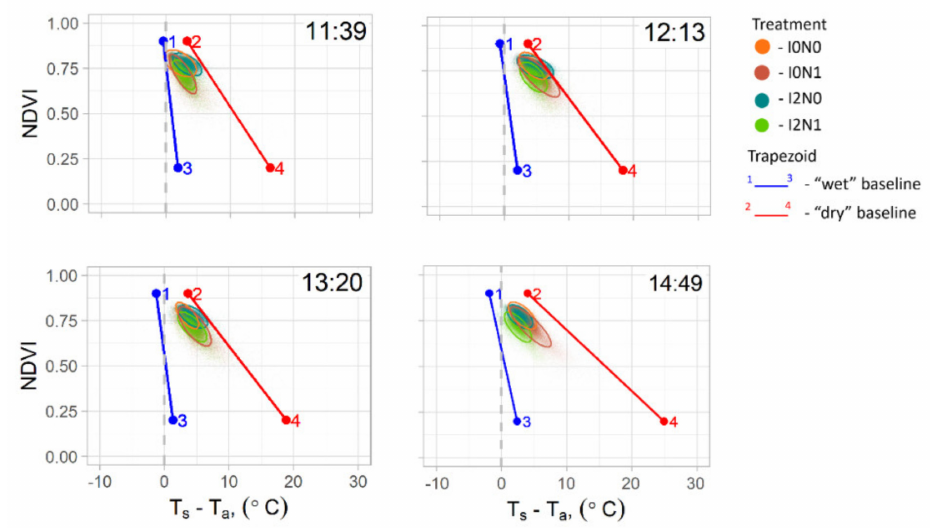
Figure 6. Vegetation index/temperature trapezoids for the winter wheat fields in Denmark on 28 June 2019. I0, I1 and I2 are minimum, optimum and full irrigation, respectively. N0 and N1 are without and with additional